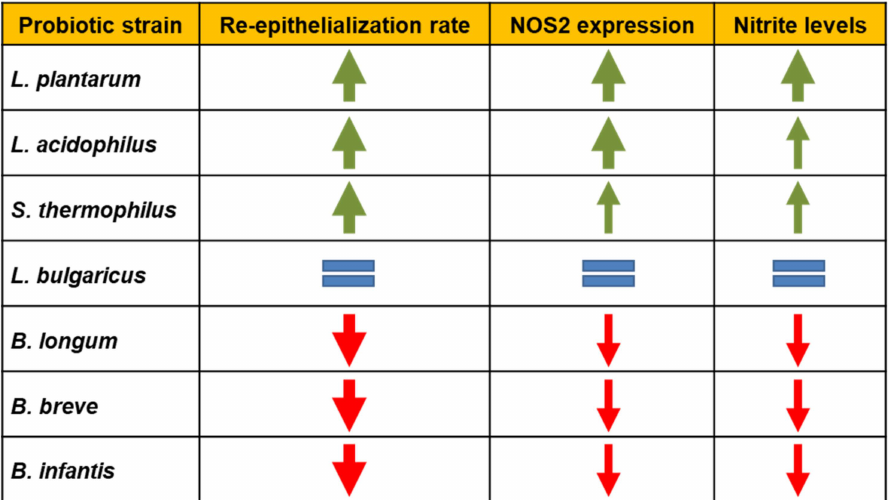
Figure 6. E ff ects of the soluble fraction from lysates of the used probiotic strains on scratched HaCaT monolayers: Overview of the re-epithelialization potential of the used probiotic strains as well as their ability to influence NOS2 protein expression and